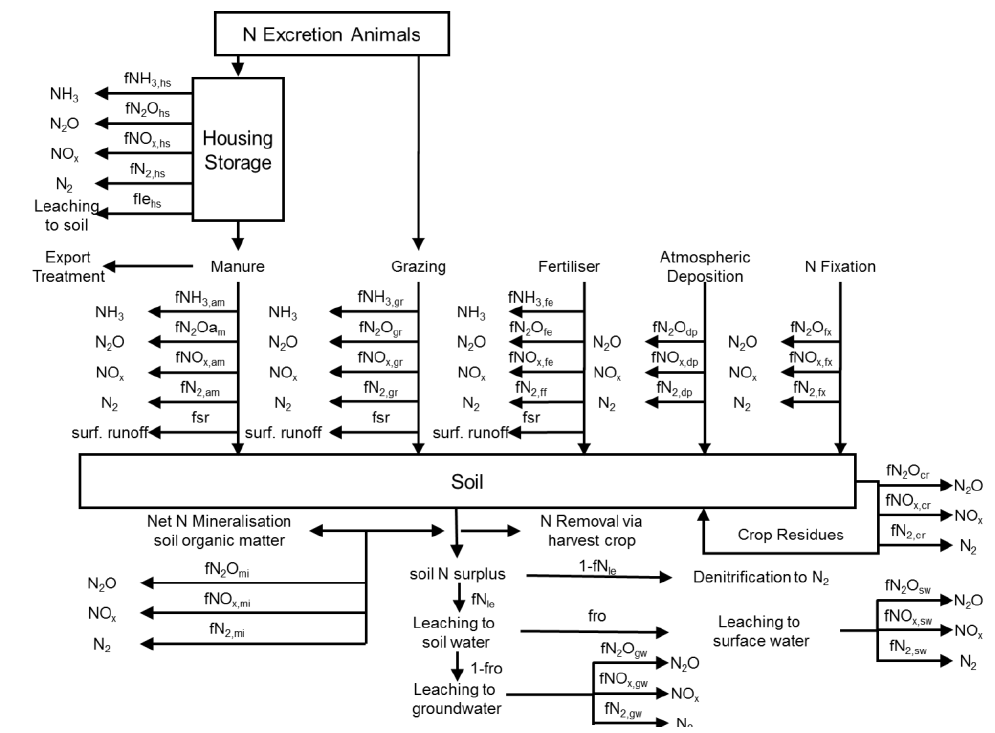
Fig. 1. N transfer processes included in the agricultural module of INTEGRATOR (the adapted MITERRA-Europe model).